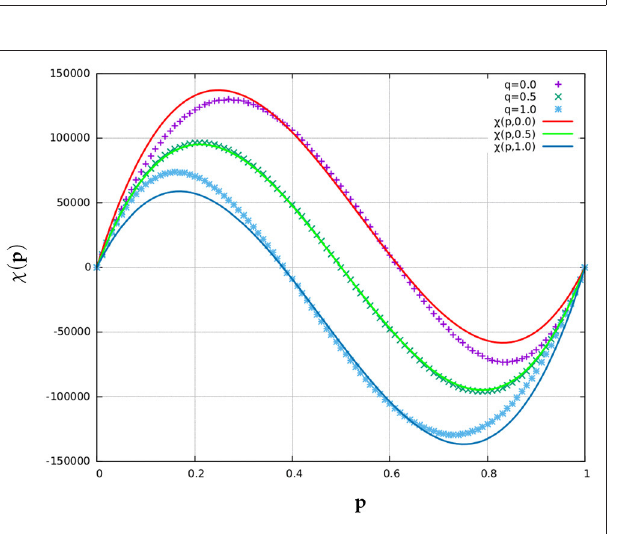
FIGURE 12 | Plot showing the cubic fit χ ( p , q ) for the Euler number χ = N B − N W statistics, collected over 100 random binary matrix configurations of size 1000 × 1000, when q = 0, q = 0.5, and q = 1, respectively. The cubic approximation works almost perfectly when q = 0.5 but its accuracy decreases as q gradually shifts from 0.5 toward either 0 or